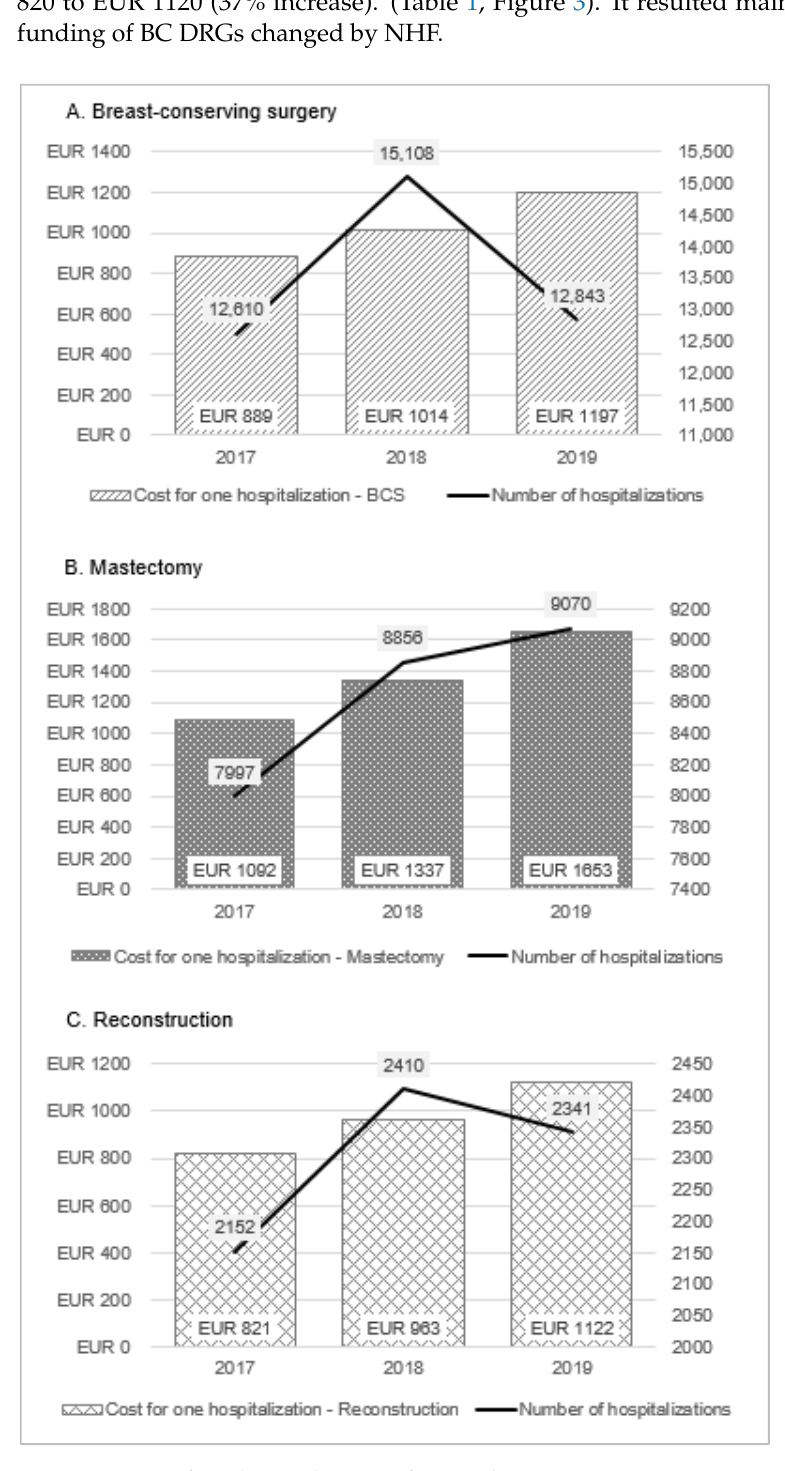
Figure 3. Costs of one hospitalization of surgical treatments.